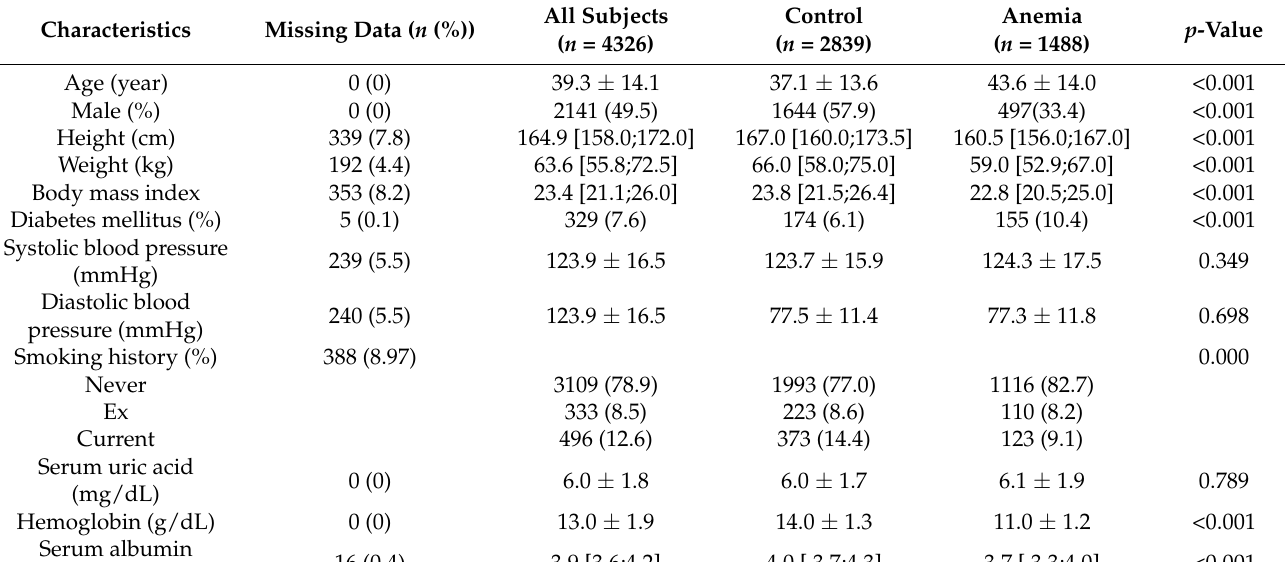
Table 1. Clinical characteristics of study